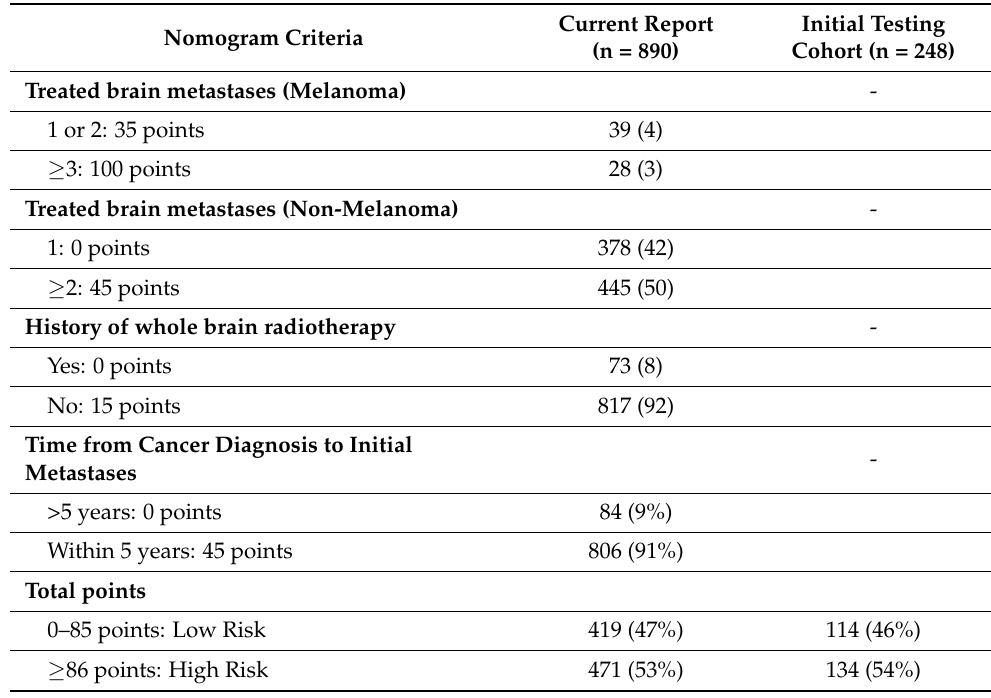
Table 3. Intracranial progression nomogram score distribution across all patients, with reference comparison to the test cohort from